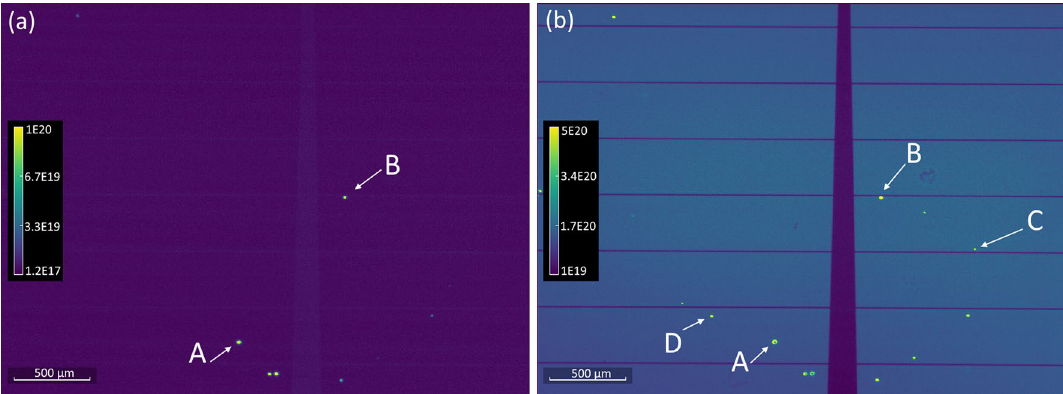
Figure 2. Photon flux maps in photons/(m 2 s eV) at 77 K and either ( a ) 730 nm, or ( b ) 846 nm, corresponding to the DBR and FB peak transitions. The immediate area around pinhole defects visible in ( a ) shows a halo of FB defect emission at 846 nm (1.46 from the incident sunlight direction 24 . Our devices were grown on top of an epitaxial distributed Bragg reflector (DBR) to provide high reflectivity near the band edge of GaAs. Figure 1b–d show a series of absolute PL images (units: photons/m 2 s eV) under a 5× objective at T = 300 K and wavelengths corresponding to the PL peak maxima of several observed transitions, including (b) 756 nm, (c) 870 nm, and (d) 894 nm. The dark horizontal gridlines and the thicker vertical line are the top electrode contact, with 350 µm spacing between the horizonal lines. The few bright spots appearing in Fig. 1b are consistent with the DBR layer’s PL signal, which we have confirmed in separate, DBR-only films (Supplemental Fig. S1). There- fore, we attribute the emission at 756 nm to emission from the DBR transmitted out of the top layer through pinholes within the film, and not the GaAs active material. The emission at 870 nm (1.425 eV) is attributed to the fundamental band gap E g (300 K) of GaAs (i.e., the BB transition), and although the device contains a doped GaAs layer, the band gap energy is unaffected by Moss–Burstein effects at the low n-doping concentrations in this device 25 . The penetration depth of the 532-nm laser used for these PL measurements is approximately 135 nm, therefore mostly interrogating the low-doped n-GaAs region of these cells. We observe a relatively uniform response across the image except at the location of the pinholes or a few other local defects appearing as darker blue in Fig. 1c. At 894 nm (Fig. 1d), the BB signal is low but a few bright spots appear at locations mostly (but not all) corresponding to the pinhole sites. The signal at these sites is very weak near room temperature but becomes